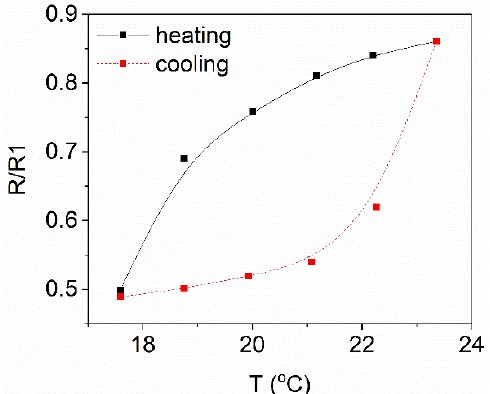
Figure 5. Bolometric hysteresis loop for the normalized resistance of VAGs.